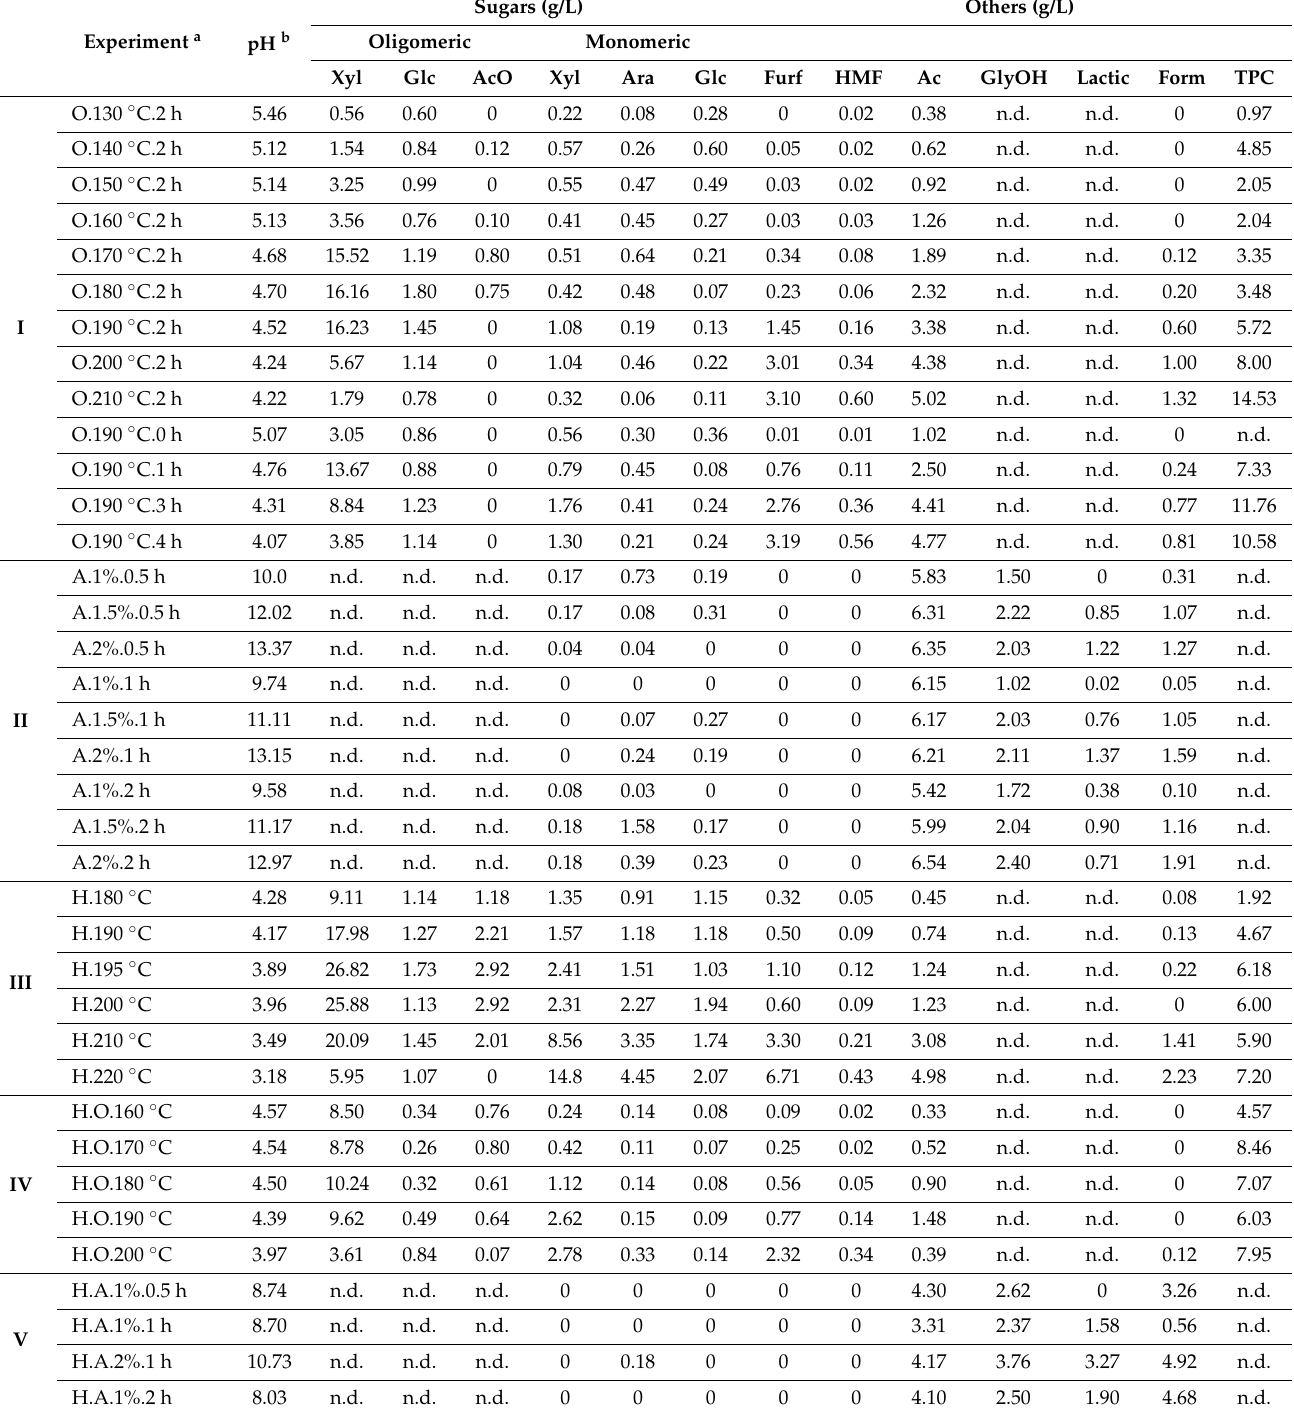
Table 3. Composition of hydrolysates obtained from organosolv, alkaline, autohydrolysis, and combined treatments applied to corn